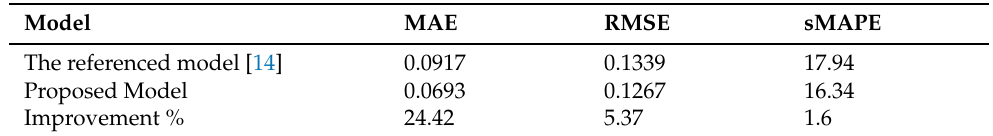
Table 7. Metrics comparison of the proposed model.